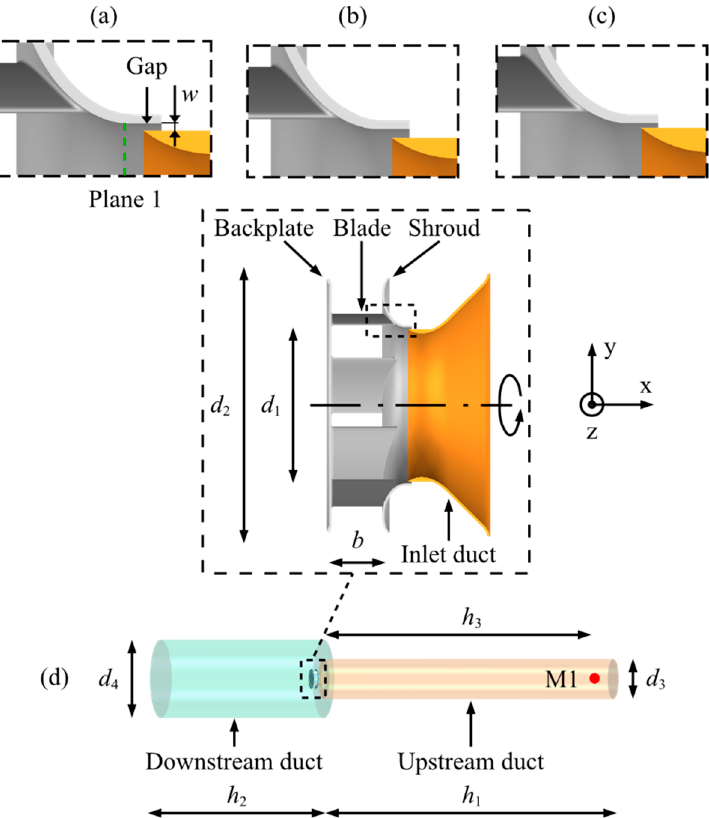
Figure 1. The fan configurations. Gray indicates the rotating fan and brown the stationary inlet duct. ( a ) Case 1 (baseline), ( b ) Case 2 (with a larger gap width = w ), and ( c ) Case 3 (with a smaller gap width = w ). ( d ) The simple geometry layout for the numerical simulations. M1 is the microphone position. The rotation axis of the fans is the